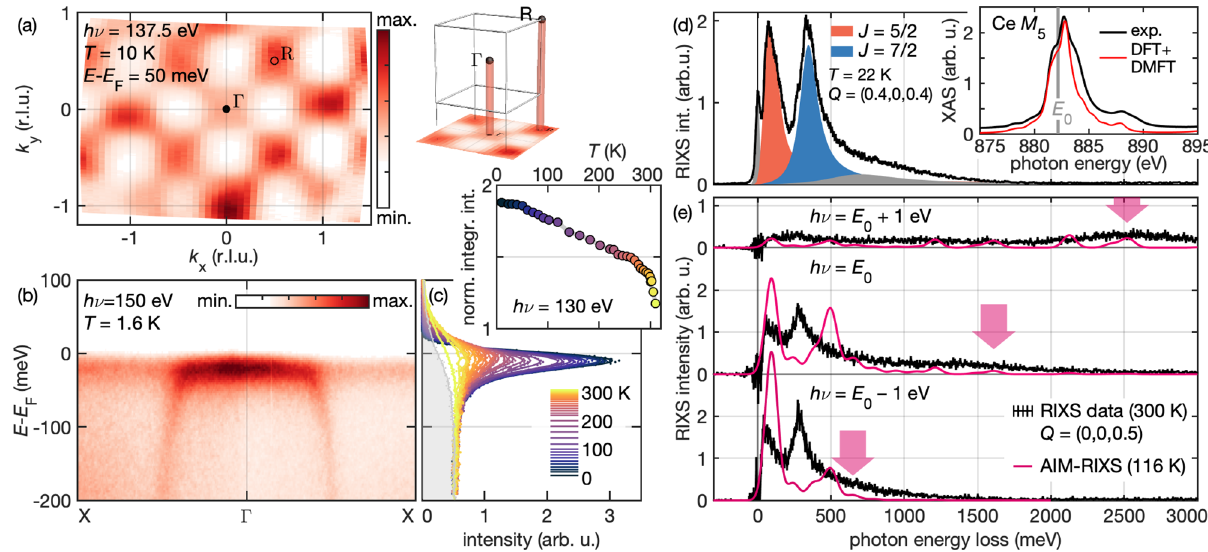
Fig. 2 | Comparison of our model with spectroscopic data, covering the elec- tronicstructureofCePd 3 fromthemeVtotheeVscale. Foraglobalcomparison of the DFT+DMFT calculation with the prototypical Kondo lattice material, we employ three spectroscopic methods. a – c Vacuum ultraviolet angle-resolved photo emission spectroscopy (ARPES) reveals the electronic spectral function A ( k , ω ) with meV resolution. a Low-temperature quasiparticle Fermi surface observed by ARPES. As the momentum along the surface normal is not resolved, the pockets Γ and R are projected onto the k x – k y plane (cf. illustration of the Brillouin zone). b High-resolution ARPES spectrum highlighting the hybridization ofthealmostverticalPd4 d bandswiththeCe4 f statesatthe Γ point. c Temperature dependence of energy distribution curves of this Kondo resonance. The gray sha- ded area is the reference spectrum of a gold foil at 310K. The inset shows the integrated intensity of f -electronic density of states normalized to the integrated intensity of the metallic background, as approximated by the gold